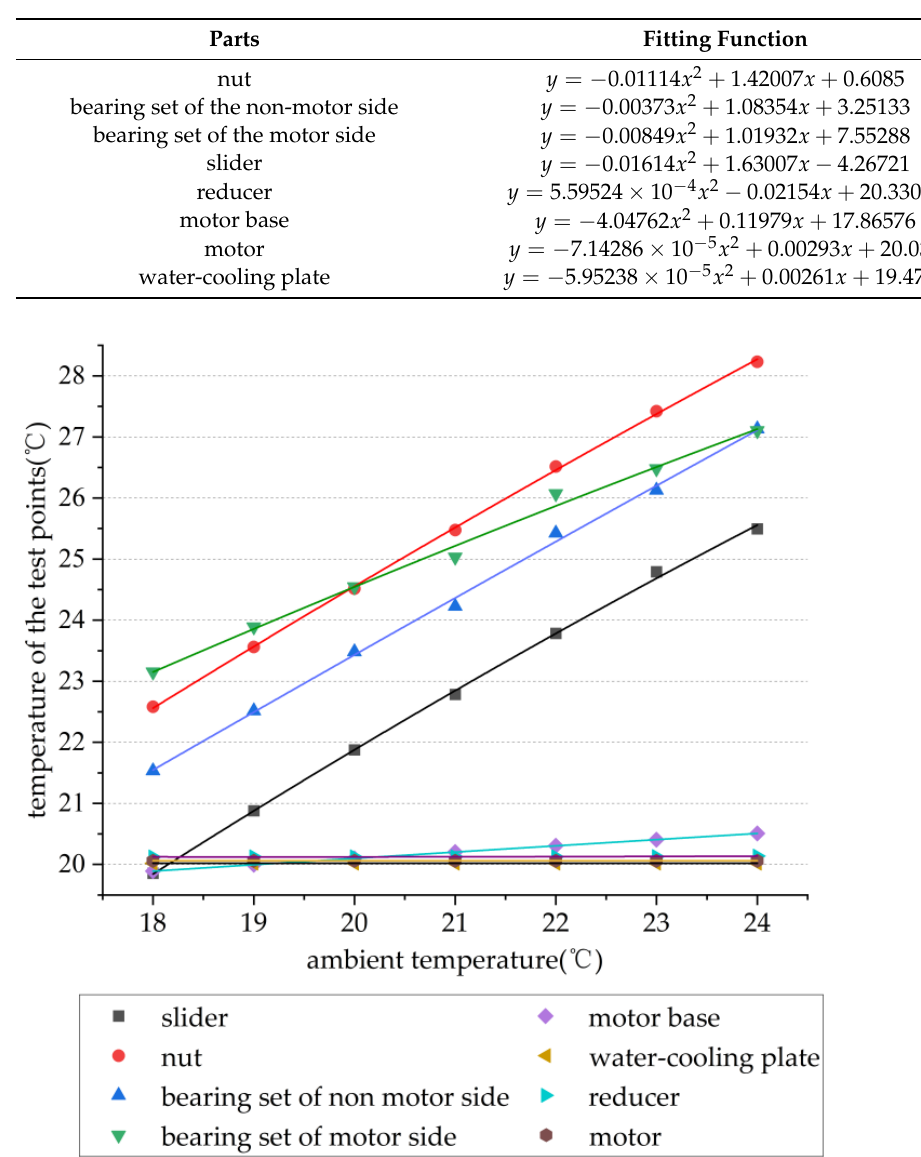
Figure 21. Effect of different environments on the temperature of the test points.